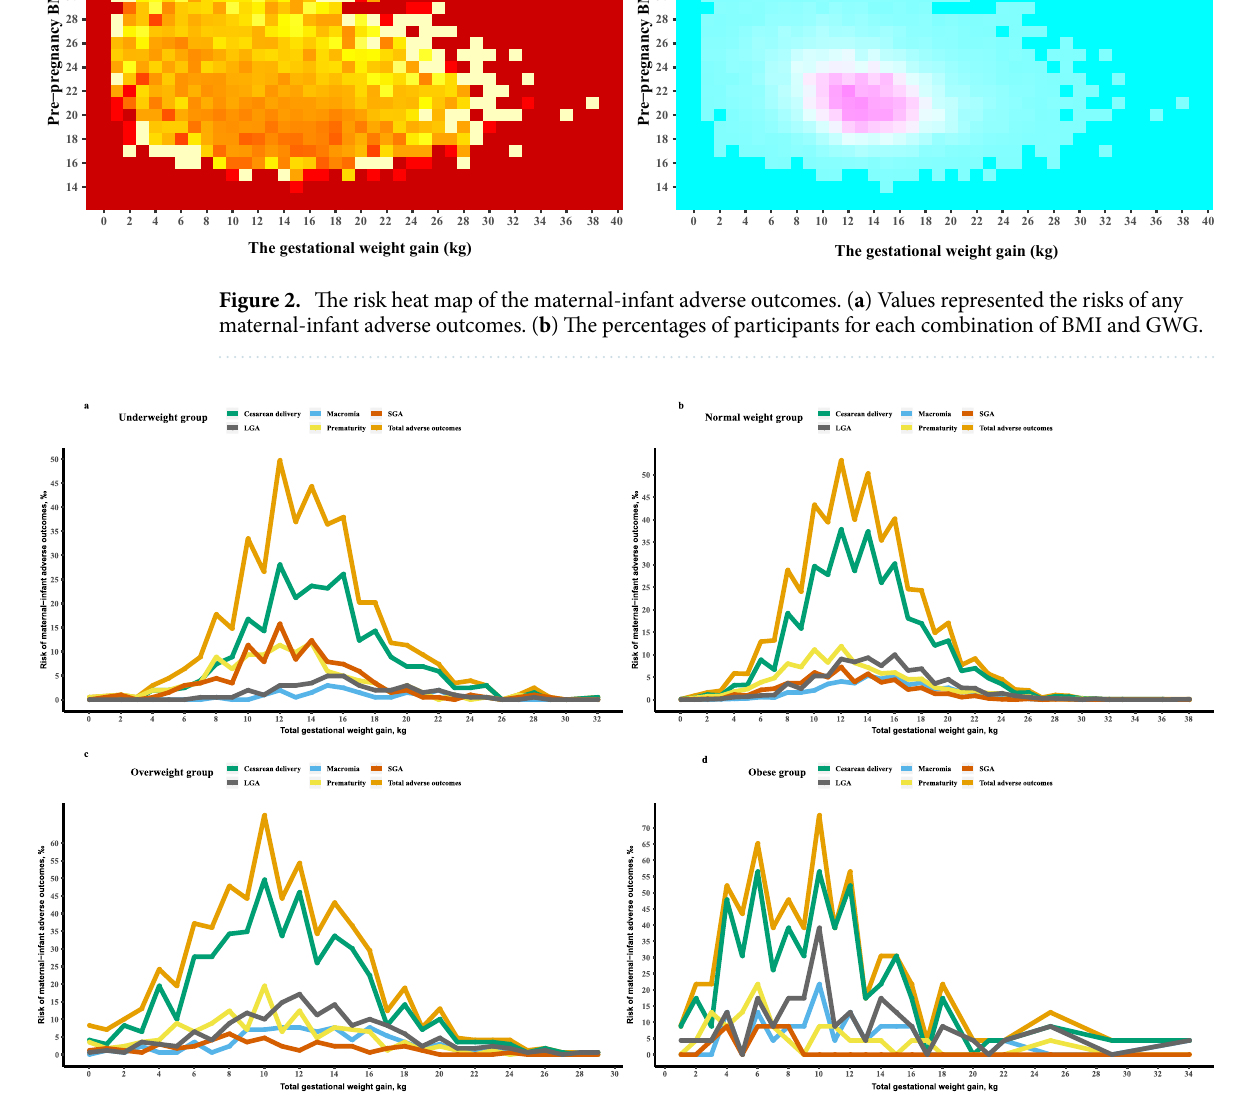
Figure 3. The risks of the maternal-infant adverse outcomes in four pre-pregnancy BMI subgroups. ( a – d ) The risks for adverse maternal-infant outcomes in underweight, normal weight, overweight and obesity group were demonstrated respectively. LGA large for gestational age, SGA small for gestational